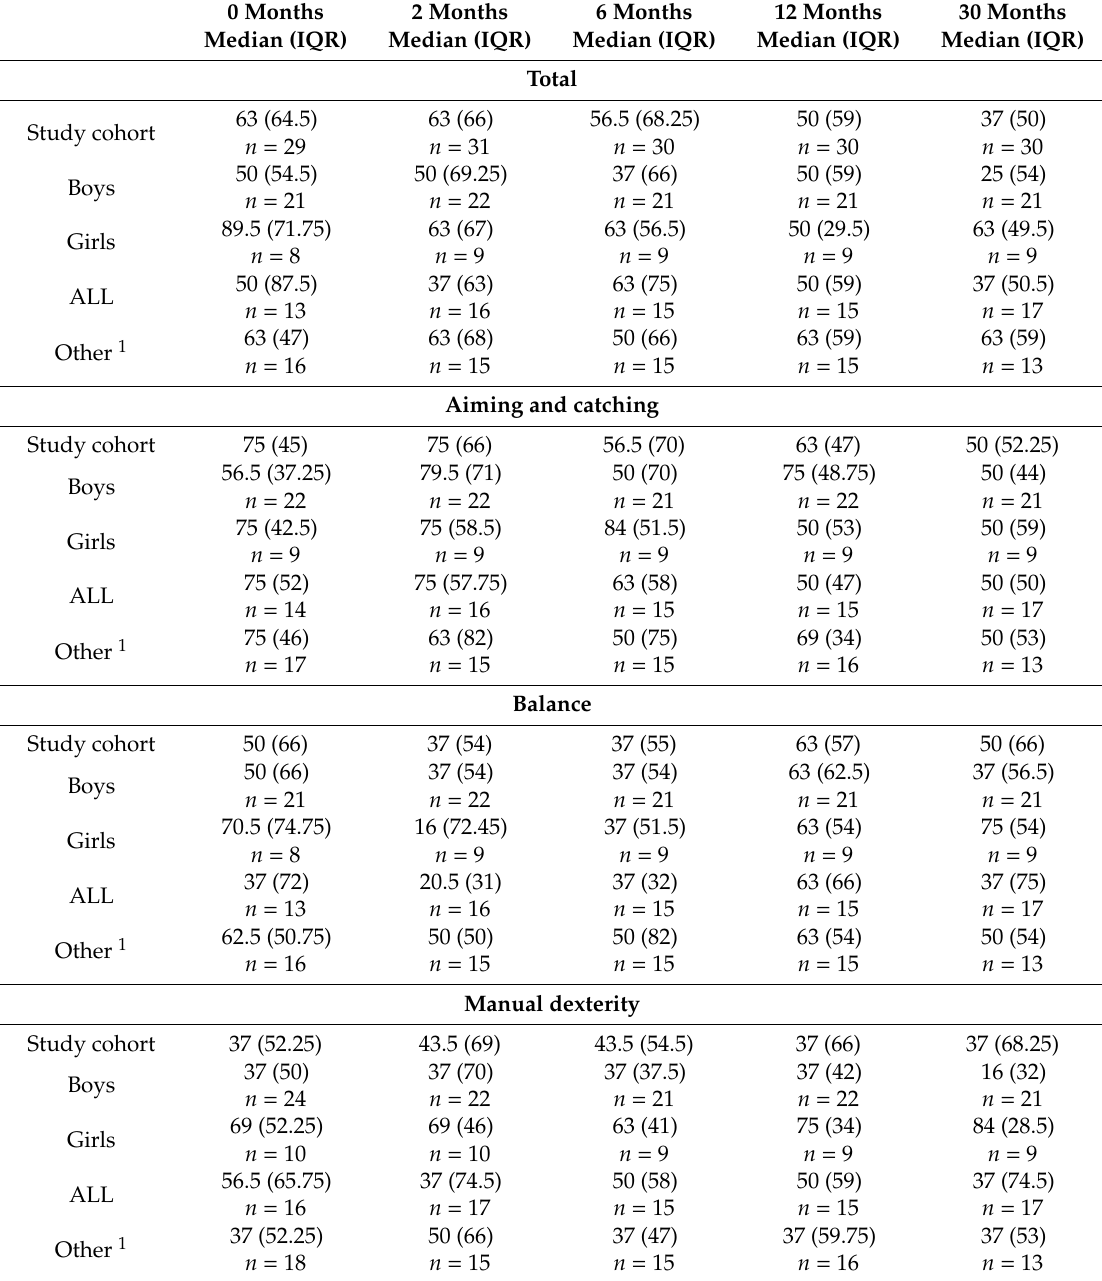
Descriptive values of movement ABC-2 percentiles during treatment (ALL = acute lymphoblastic